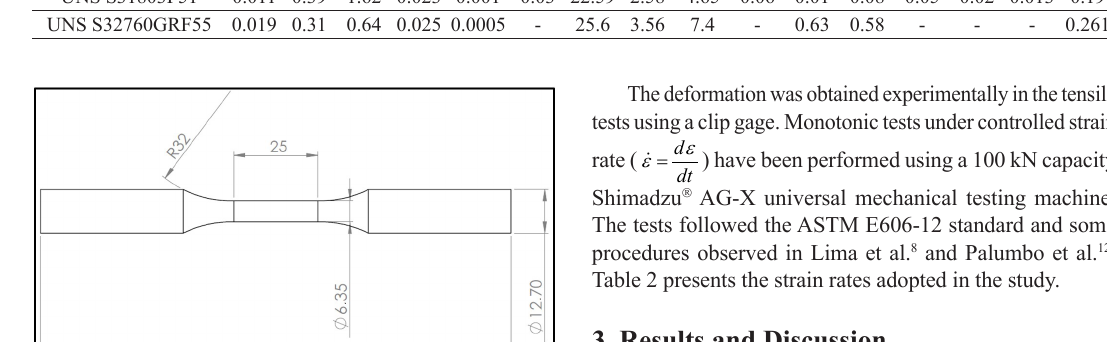
Table 1. Chemical composition (%) of the duplex and superduplex steels. Material